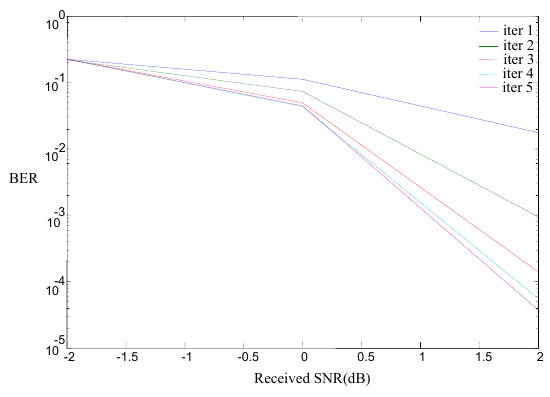
Fig. 10: The achieved BER for received SNR in (-2dB, 2dB) intervals in different iterations.